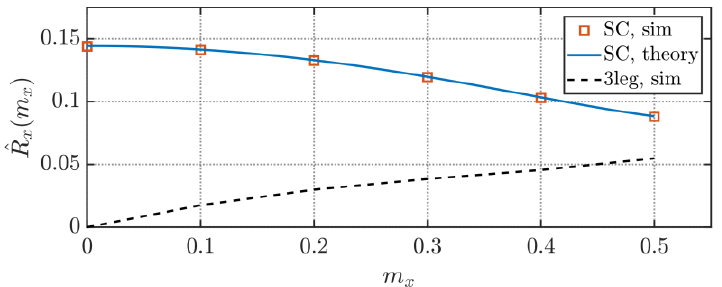
Figure 6. Three-phase split-capacitor converter normalized RMS numerical data points (red squares, “ sim ”) and analytical profile (solid line) of phase current ripple as a function of the modulation index m x . Three-phase three-leg (“ 3leg ”) normalized current ripple RMS (in case of SPWM) comparative trace (dashed).